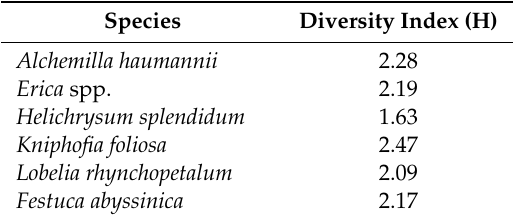
Table 2. Phenol Diversity Index.